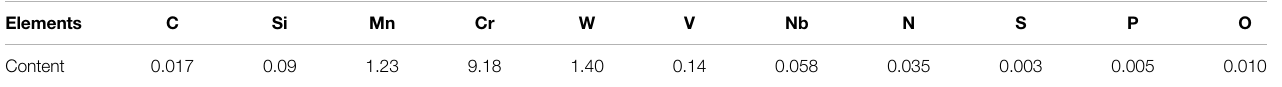
TABLE 1 | Chemical composition of the NSM steel in wt%.